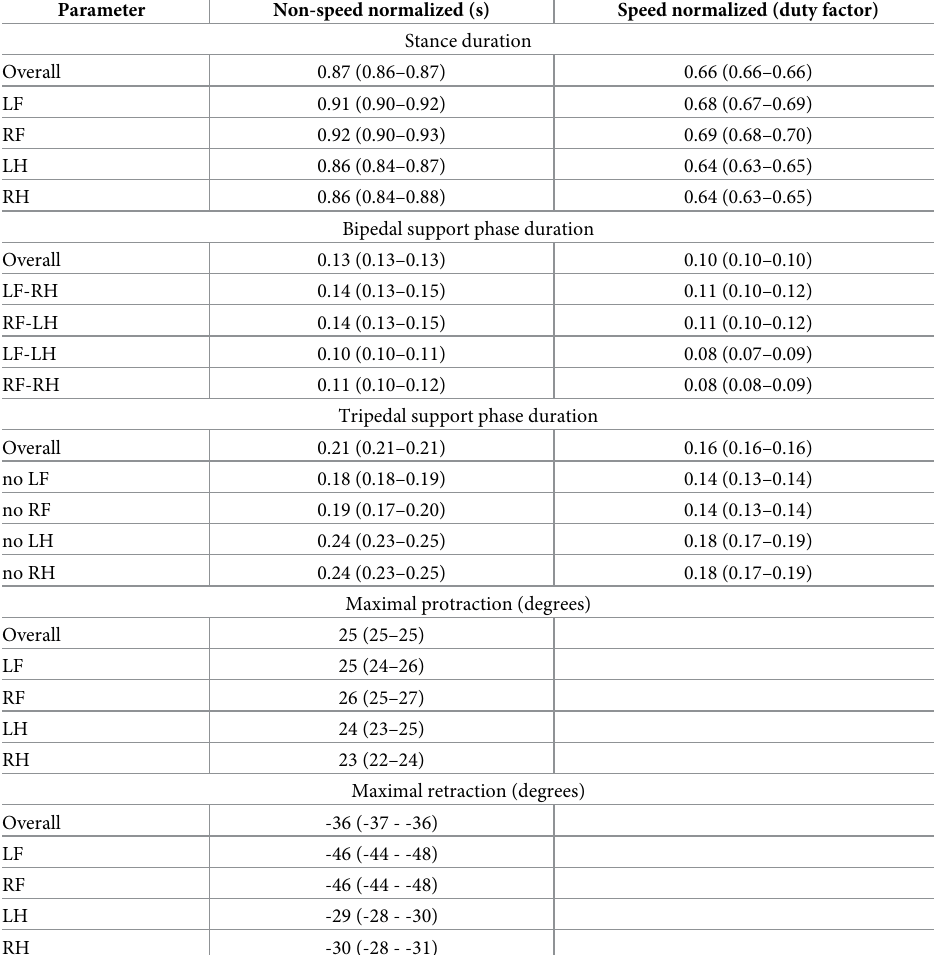
Table 2. Summary of the temporal parameters and distal limb angles. The median values and 95% confidence intervals based on the LMM analysis are estimated over all cows and steps for every limb (pair) separately. The median values are given in seconds for the non-speed normalized conditions, in fractions of the entire stride duration (i.e. duty factor), and in degrees for the distal limb